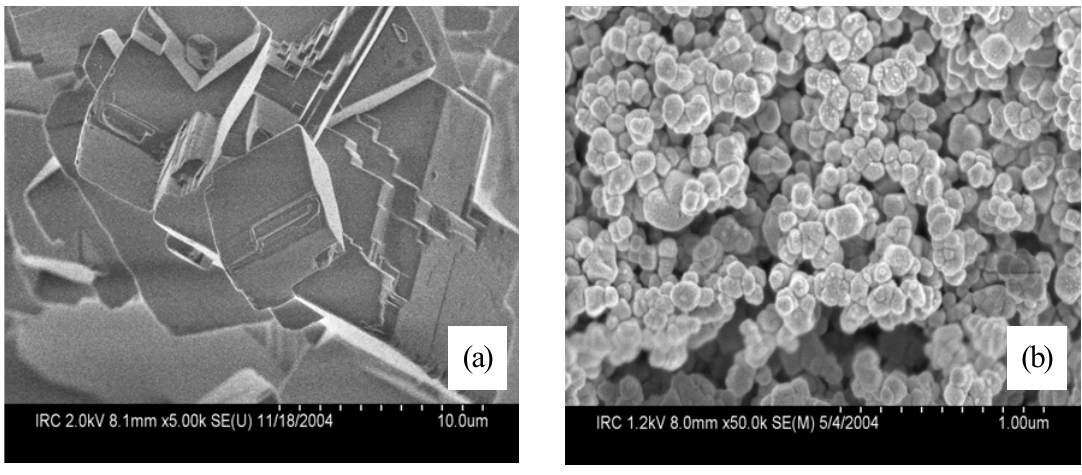
Figure 13. Rate of heat development measured by the conduction calorimeter.